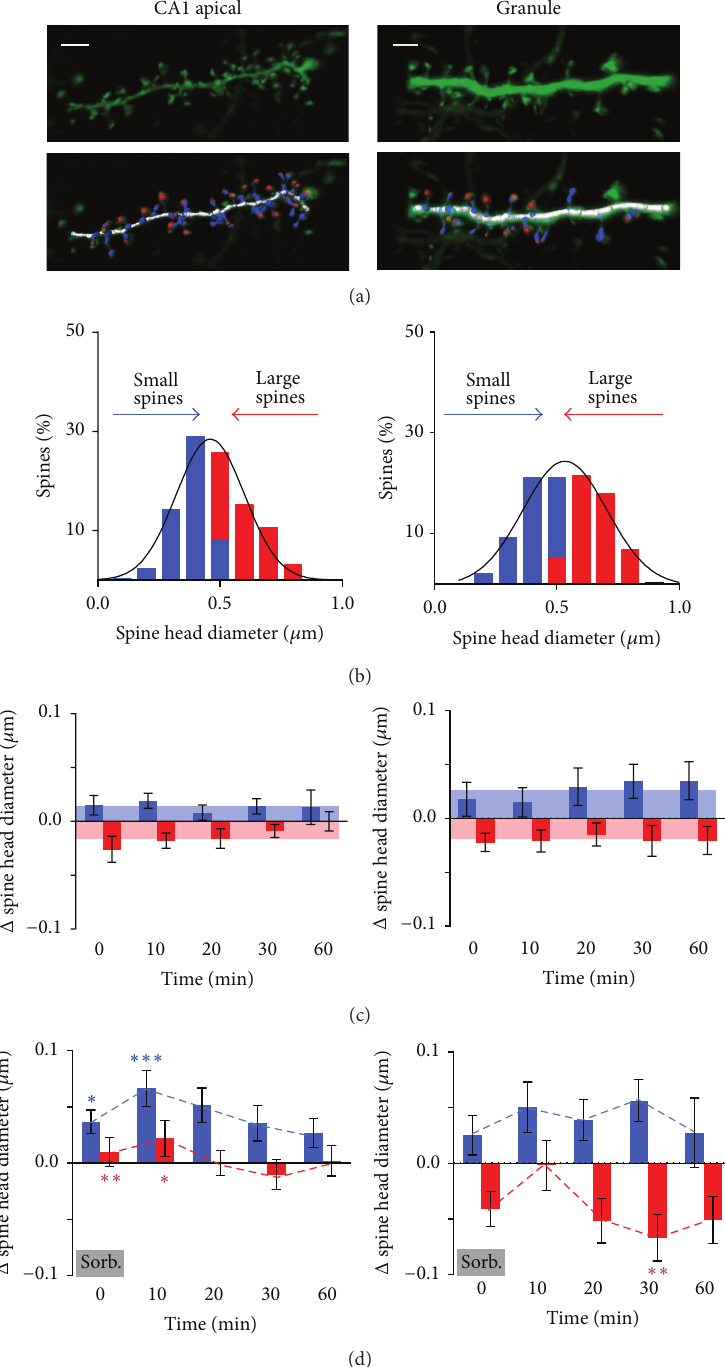
Figure 1: Control data from CA1 pyramidal cells or DG granule cells tend to fluctuate towards the mean but are similar over time (left panels: CA1 pyramidal cells; right panels: DG granule cells). (a) 3D reconstruction of deconvolved confocal images of sections of dendrite of a hippocampal organotypic slice and model of the dendritic spines as superimposed by Imaris. Scale bar: 2 𝜇 m. Note one large spine not modelled by Imaris (see Section 2). (b) Before application of TEA, estimated spine head diameters are normally distributed. Small (blue) and large (red) spines are defined as spines with diameters less or greater than the mean diameter, respectively. (c) Change in spine diameter after repeated imaging in control ACSF. Limits of the shaded region represent the mean of all time points for small (blue) and large (red) spines. (d) Change in spine diameter after repeated imaging following transient high osmolarity ACSF perfusion (50mM sorbitol, 5min). Dotted line represents mean change of small (blue) and large (red) spines at that time point. Note the data at time 0 are sampled during the sorbitol wash-in. Post hoc analysis of control data versus sorbitol (3-way interaction between size, time, and treatment): ∗ 𝑝 < 0.05 ; ∗∗ 𝑝 < 0.01 ; ∗∗∗ 𝑝 < 0.001